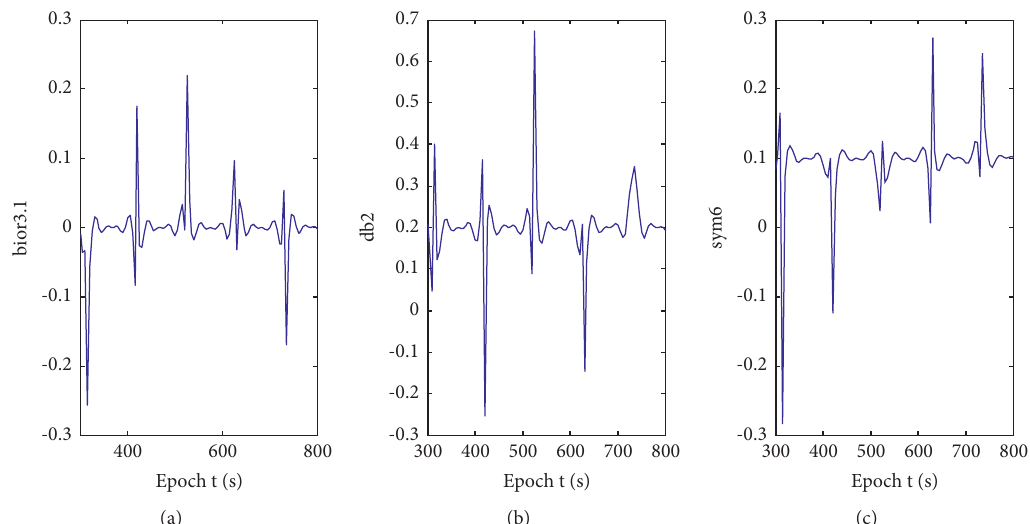
Figure 1: Comparison diagram of different wavelet detection cycle slip simulation. (a) Wavelet Bior3.1; (b) wavelet Db2; (c) wavelet Sym6.